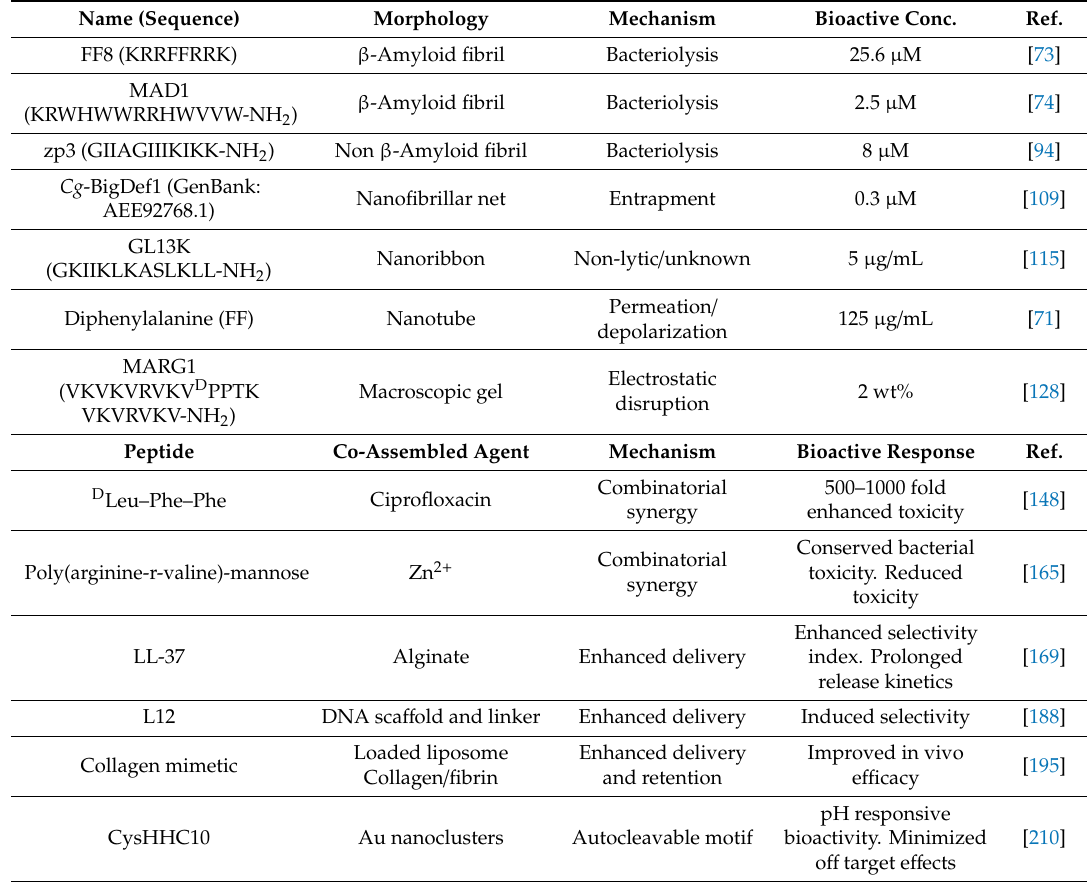
Table 1. Summary of select peptide assemblies highlighted in this